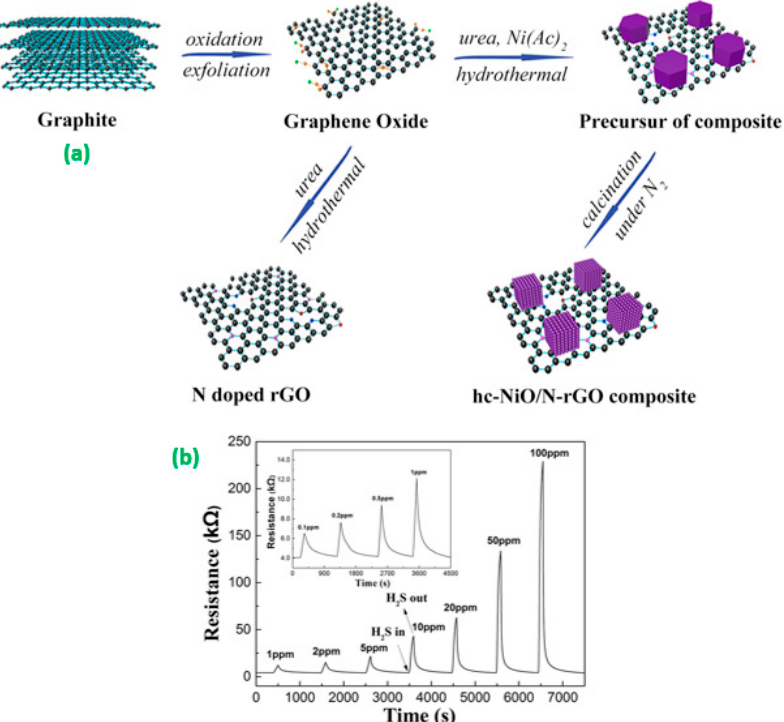
Figure 6. ( a ) Schematic preparation diagram of the hc-NiO / NrGO Composite Material and ( b ) response and recovery curve of the hc-NiO / N-rGO-based sensor toward 0.1–100 ppm of H 2 S at 92 ◦ C. Reproduced from Yang, M.; Zhang, X.; Cheng, X.; Xu, Y.; Gao, S.; Zhao, H. and Huo, L., 2017.Hierarchical NiO Cube / Nitrogen-Doped Reduced Graphene Oxide Composite with Enhanced H 2 S Sensing Properties at Low Temperature, ACS Appl. Mater. Interfaces, 9, pp. 26293–26303 [91].